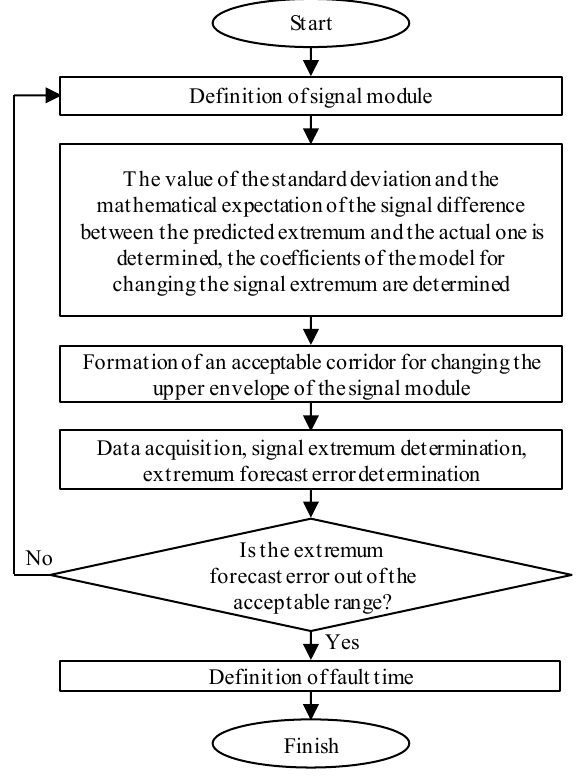
Figure 1. The block diagram of algorithm 1.